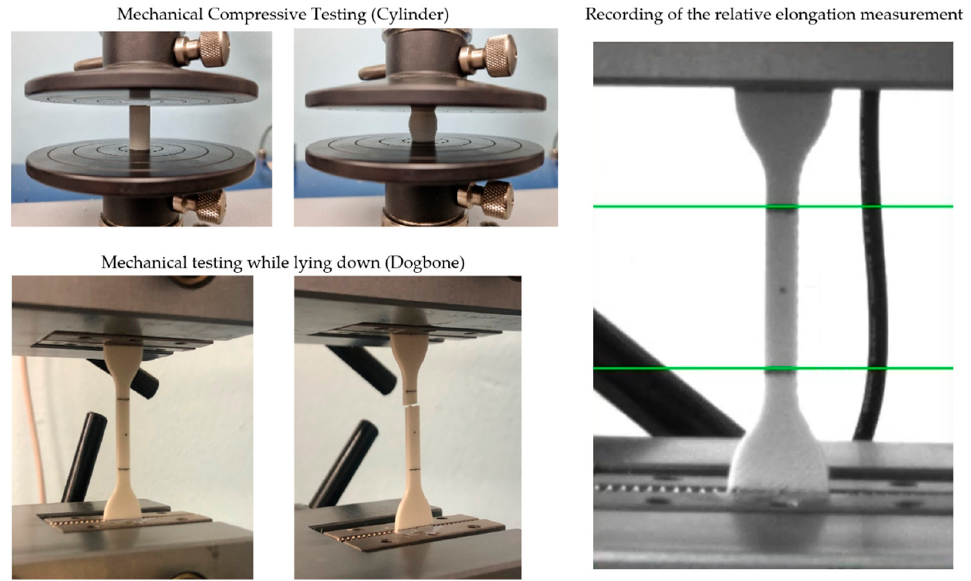
Figure 6. Mechanical tensile/compressive testing of experimental samples (Cylinder, Dogbone) and measurement of relative elongation.